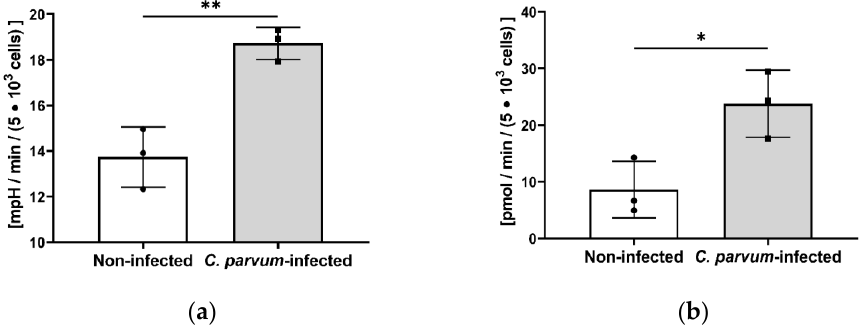
Figure 5. Effect of C. parvum infection on glycolysis and glycolytic ATP production in HCT-8 cells under hyperoxic (21% O 2 ) conditions. ( a ) C. parvum infection-triggered upregulation of glycolysis in HCT-8 cells as evidenced by Seahorse Glycolysis Stress Test Kit. ( b ) Likewise, significant infection- induced upregulation of glycolysis-derived ATP was observed. Bar graph shows mean ± SD, ( n = 3). t -test was use for evaluation of significance (* = p ≤ 0.05, ** = p ≤